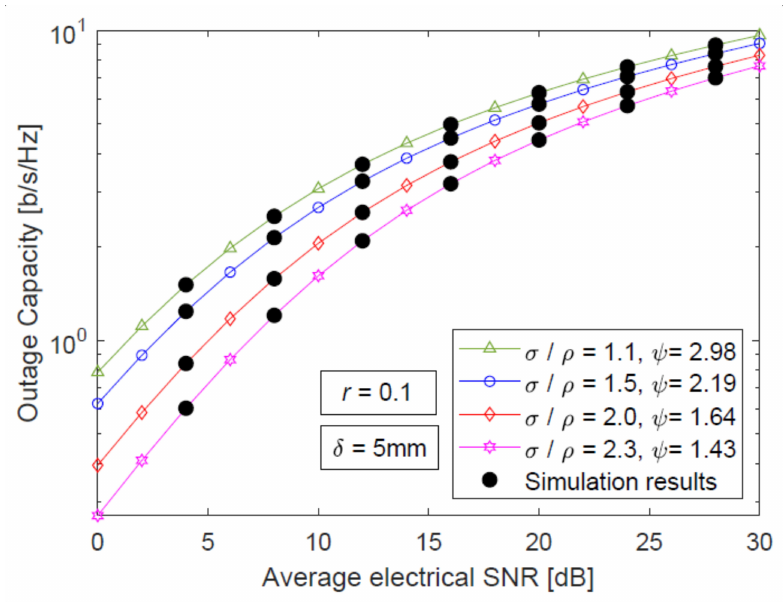
Figure 1. Outage capacity versus average electrical SNR for δ = 5 mm and r = 0.1 under the presence of varying, weak to strong stochastic pointing errors.